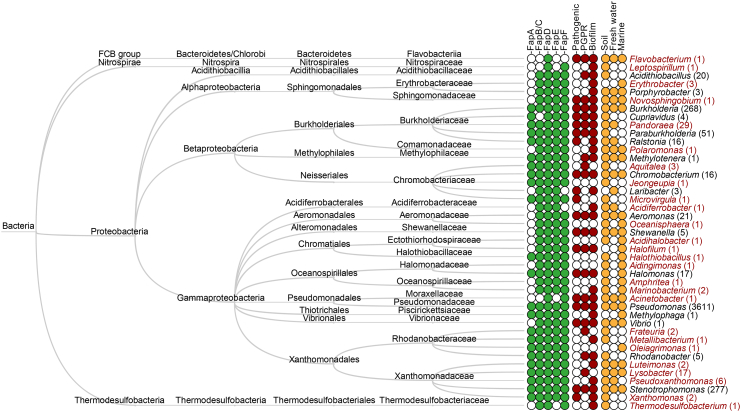
Phylogenetic distribution of the Fap system. Fap protein homologs were identified in the non-redundant bacterial RefSeq protein database v. 83 using the previously described profile hidden Markov models [17]. NCBI's Batch Entrez was used to extract metadata for identical protein groups, and this information was used to identify genomes containing fap-operon homologs. Only proteins that were encoded in a fap-operon (< 5000 bp to second nearest fap-gene neighbor) with at least four fap-gene homologs were included in the analysis. This was done to remove false positives. The taxonomic analysis was performed based on the NCBI taxonomy and visualized using MEGAN 6.0 [19]. Numbers in parentheses indicate the number of strains containing Fap systems within each genus. Note that these numbers are highly influenced by the number of sequenced strains within each phylogenetic group and therefore do not reflect the prevalence of Fap systems within these groups. Genera highlighted in red represent new genera where the Fap systems have been identified in this study. The presence of individual Fap components and selected metadata and habitat for each genus is illustrated in the filled circles left of the genus names. PGPR, plant growth promoting rhizobacteria.